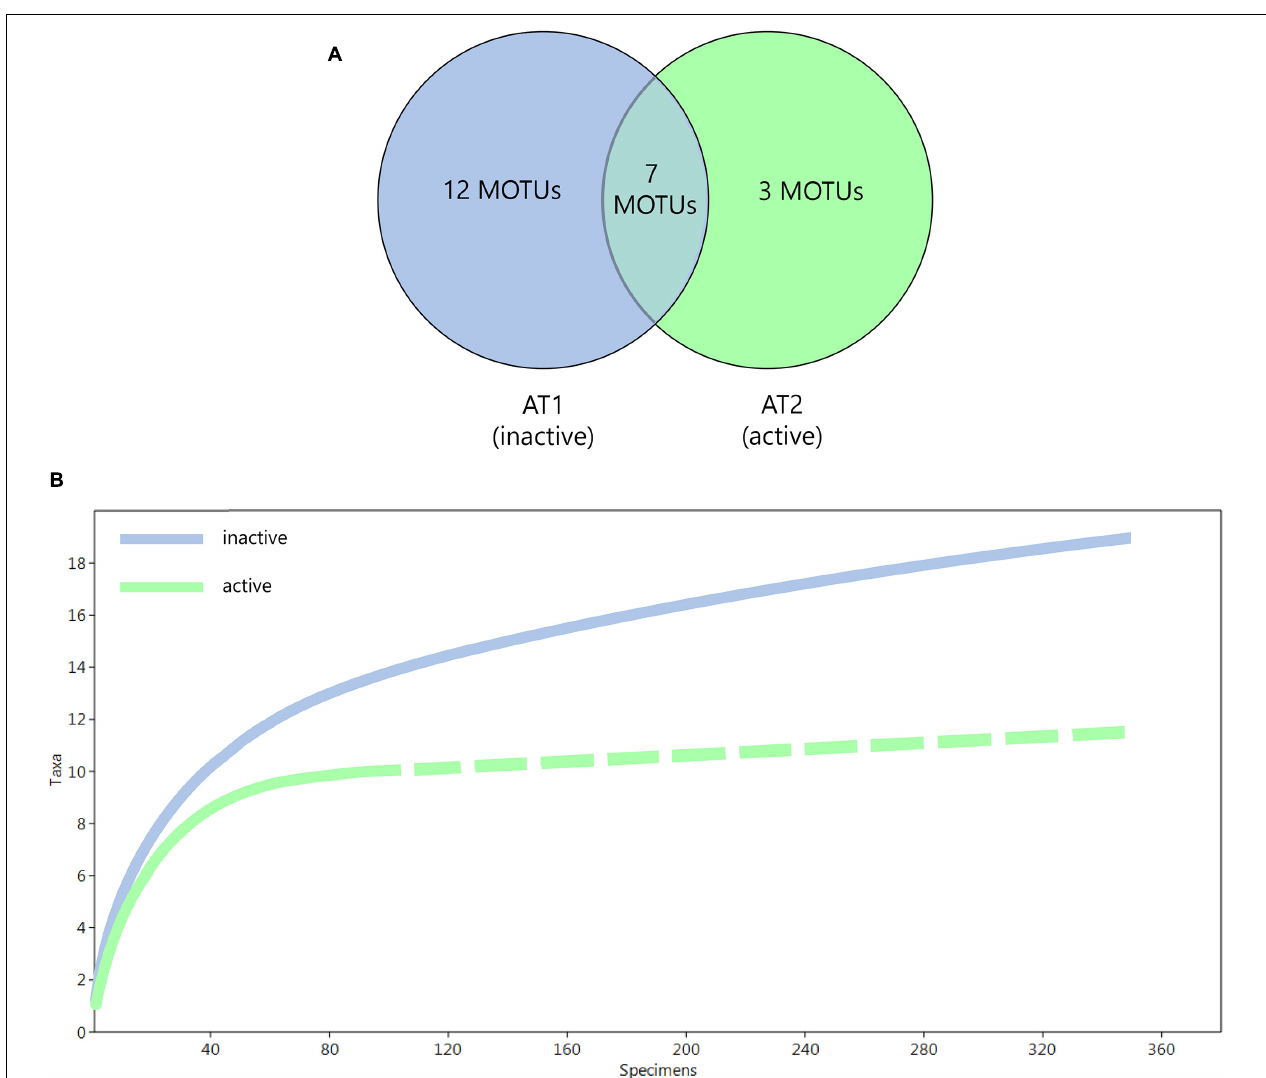
FIGURE 6 | Comparison of active and inactive sites. (A) Venn-diagram presenting the different MOTUs and their collection locations. (B) Assessment of the species richness by individual-based rarefaction